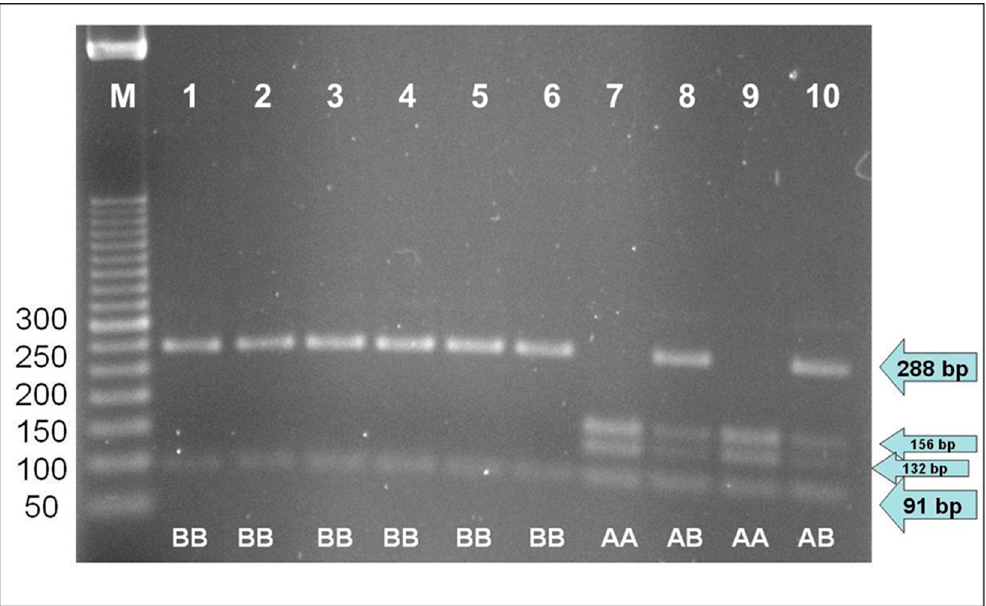
Figure 1. PCR-RFLP genotyping at bovine CSN3 . Lane M: marker; lanes 1 to 6: genotype BB, Sardo-Modicana cattle breed; lanes 7 and 8: genotypes AA and AB, Sarda cattle breed; lanes 9 and 10: genotypes AA and AB, Sardo-Bruna cattle breed. Table 1. Results of genotyping at CSN3 locus in Sardinian local cattle breeds (n = 158). Breed n %Gen ObsHet PredHet HWpval MAF Alleles